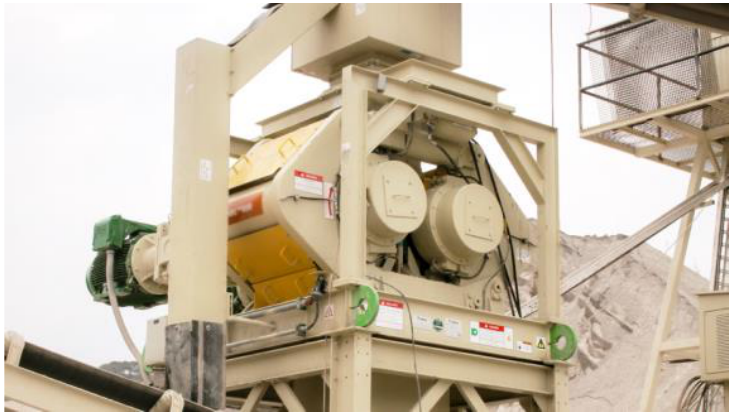
Figure 1. HRC™ Aggregates installed in an industrial operation.